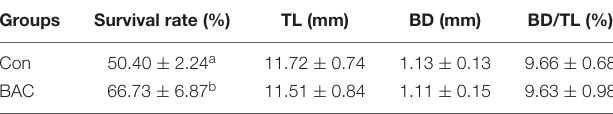
TABLE 1 | Survival rate, total length (TL), and body depth (BD) of Anguilla japonica larvae. Groups